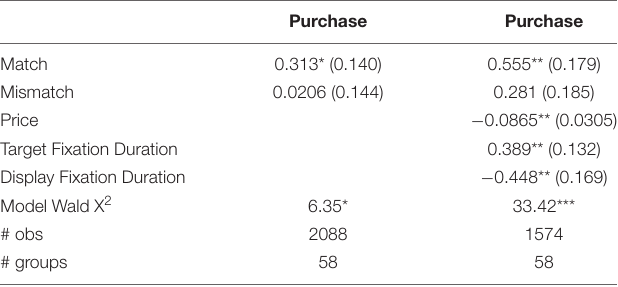
TABLE 1 | Mixed effects logistic regressions examining factors related to target purchase.